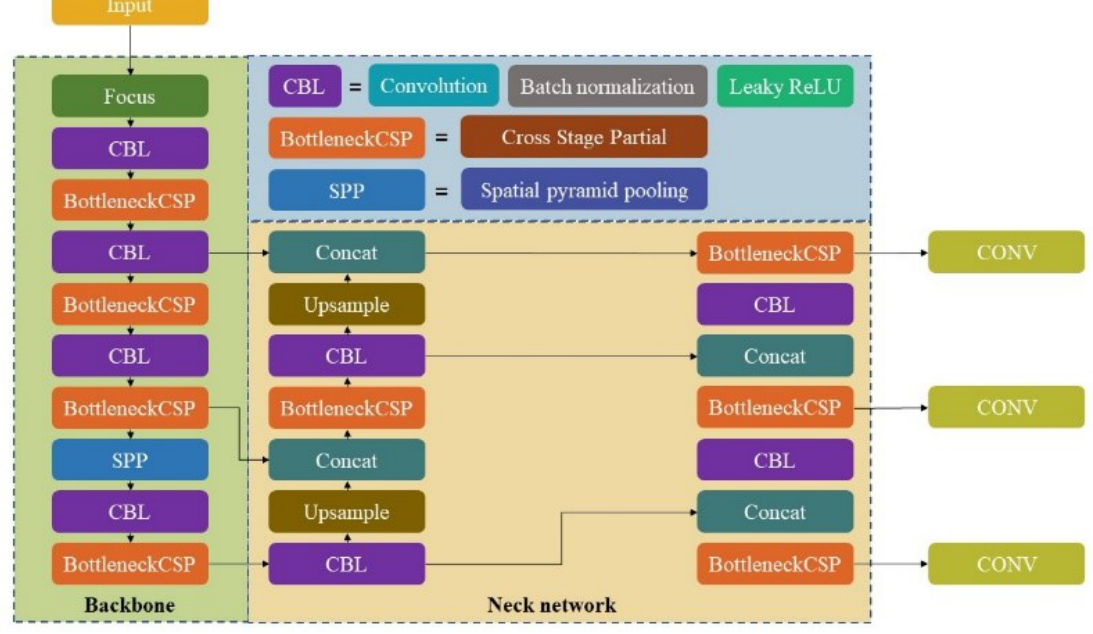
Figure 6. YOLOv5 structure.